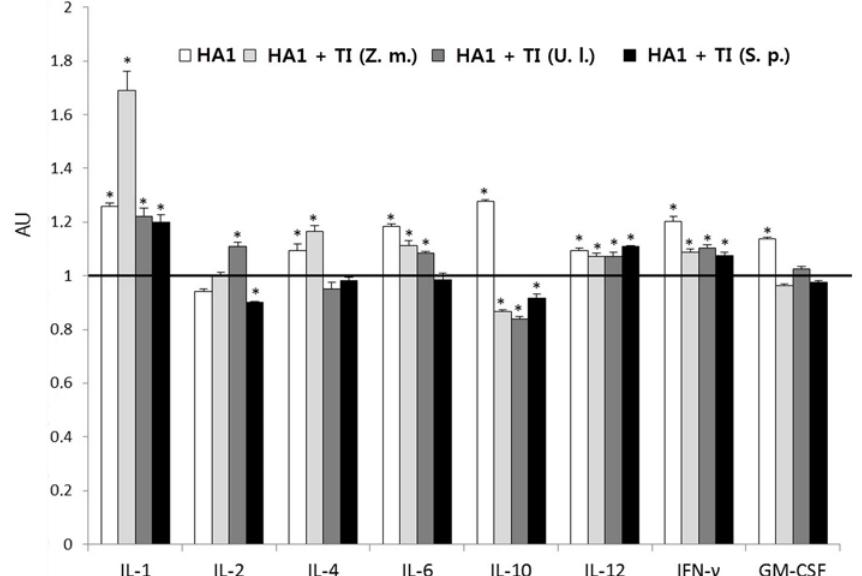
Figure 2. The content of cytokines depending on the monogalactosyldiacylglycerol (MGDG) source. The content of cytokines was evaluated as described in the legend of Figure 1. Data are presented in arbitrary units (AU) relative to the control value equal to 1. Results are expressed as means ± SD of six observations. * p < 0.05 as compared with the control.